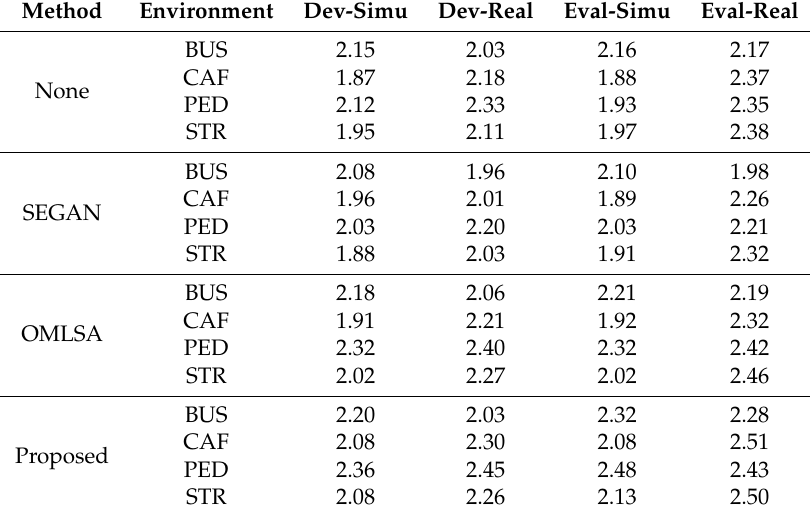
Figure 4. SDR (dB), eSTOI and STOI scores for speech quality test on the development set and evaluation set. ( a ) SDR (dB), ( b ) STOI, ( c ) eSTOI. Table 1. PESQ scores for speech quality test on the development set and evaluation set for each environment.